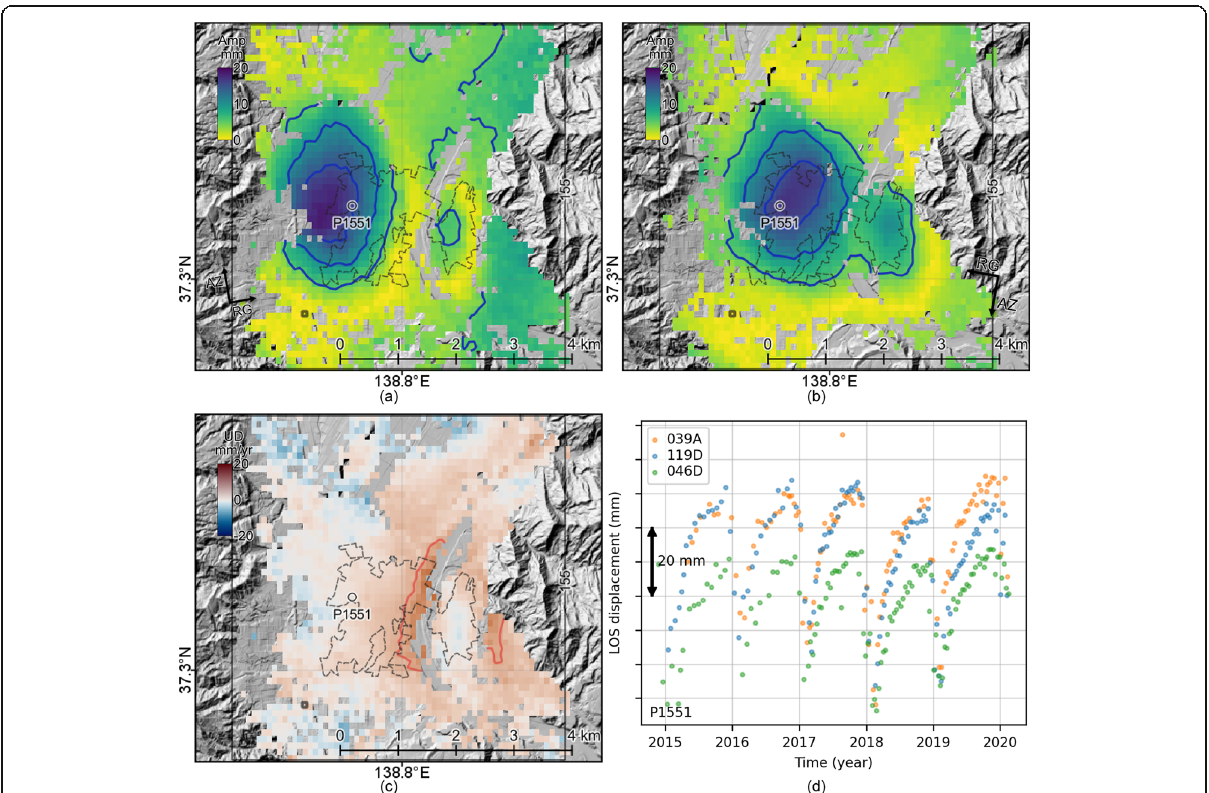
Fig. 8 a Amplitudes of the annual LOS fluctuation in Ojiya (ID: 155) from the ascending 039A_05372_151515. The black lines denote the outlines of the DID. The interval of the contour lines is 5 mm. The black square denotes the reference point. b Amplitudes from the descending 119D_05226_070704. c Vertical deformation velocities. The interval of the red (uplift) contour lines is 5 mm/year without the 0 mm/year lines. d LOS deformation time series at P1551 for each